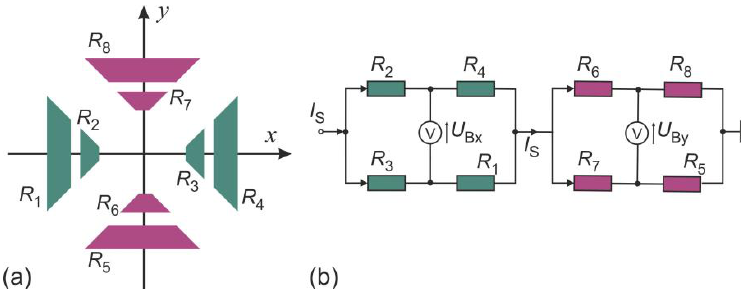
Figure 6. ( a ) Schematic illustration of the transducer with trapezoidal shaped thermistors arranged